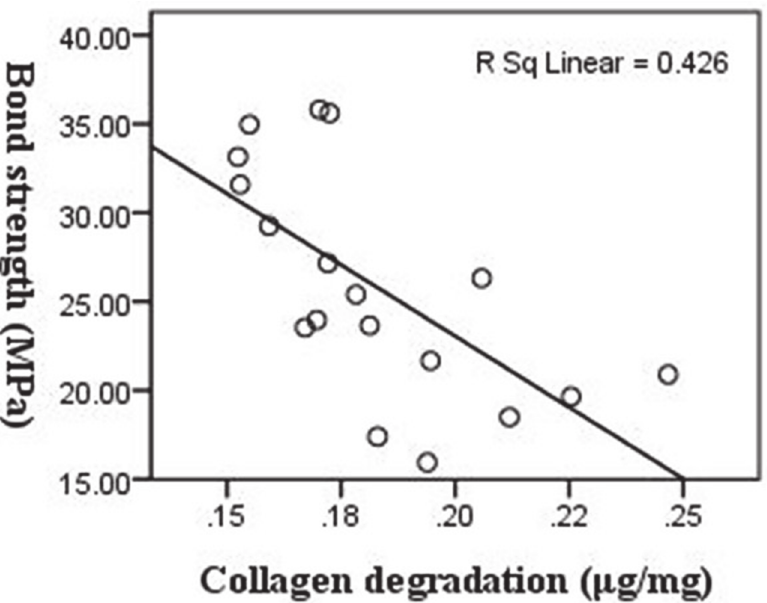
Fig 1. Scattered plots of linear analysis regression showing negative correlation between collagen degradation and μ